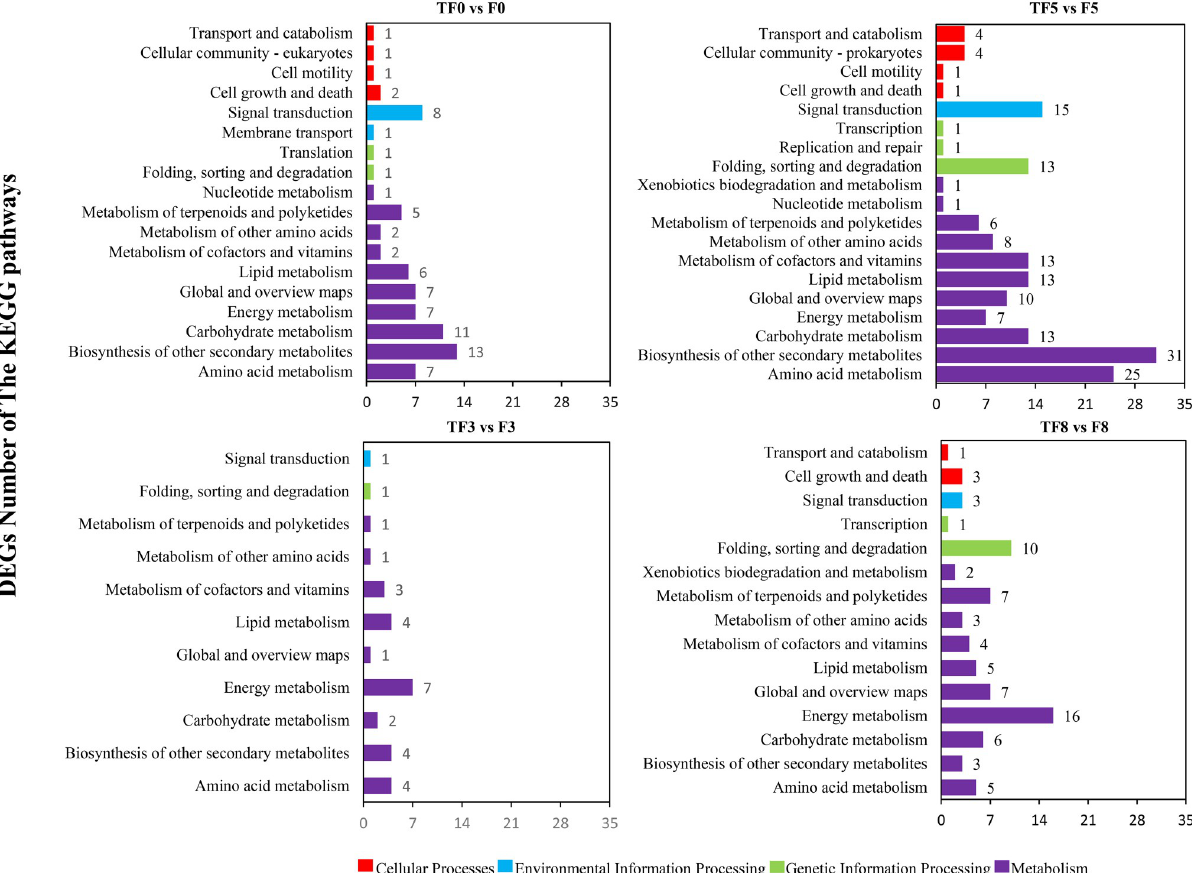
Fig 4. KEGG pathway (A) classification of differentially expressed genes. Application of T . asperellum M45a (TF). The noninoculated control (F).